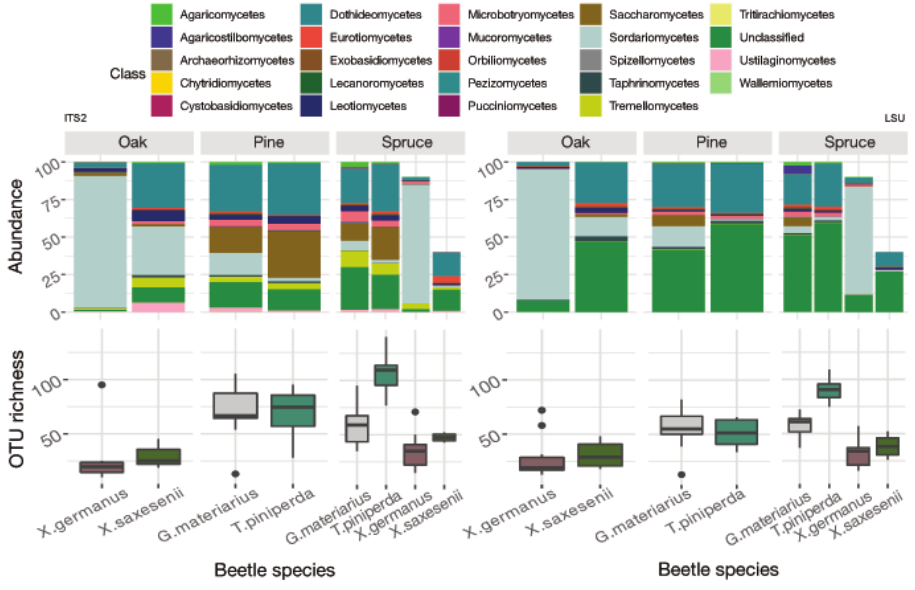
Figure 2. Top panel: The proportion of OTUs identified as members of a fungal Class determined by the ITS2 and LSU D1-D2 regions. For the spruce forest, only nine X. germanus and four X. saxesenii specimens were retained after rarefaction. Lower panel: The number of fungal OTUs per beetle specimen, separate for each beetle species and forest type, for ITS2 and